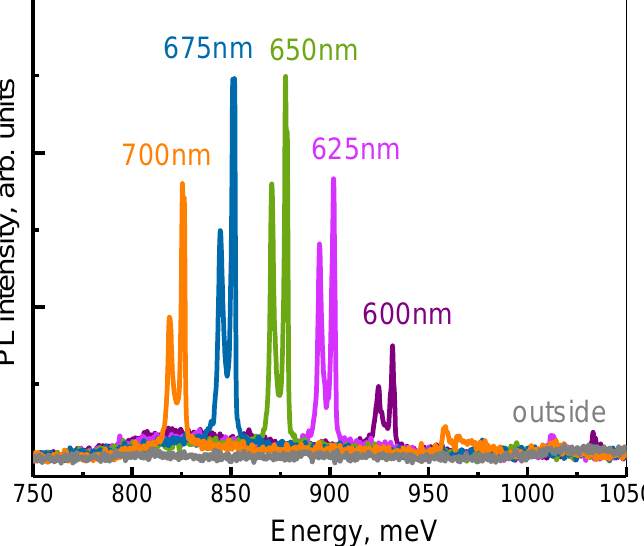
Figure 6. The DPL spectra of the PCSs with different periods ( a = 600 ÷ 700 nm) in comparison to DPL spectra of the area outside of PCS. The collection angle is 2 Θ ~ 15°.